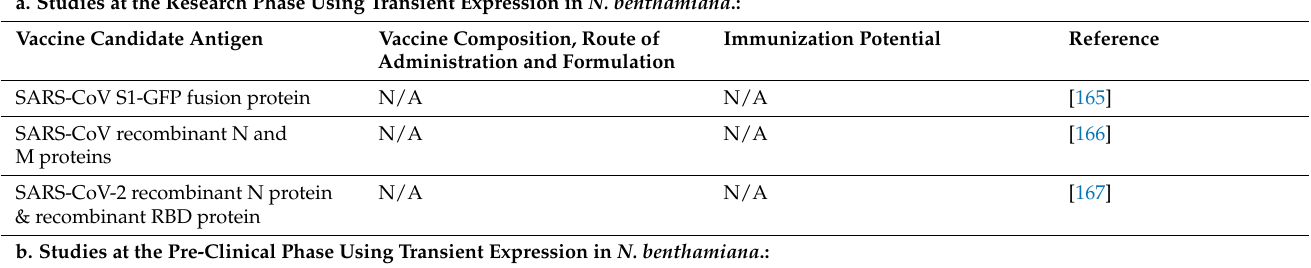
Table 2. List of plant-based vaccine candidates against